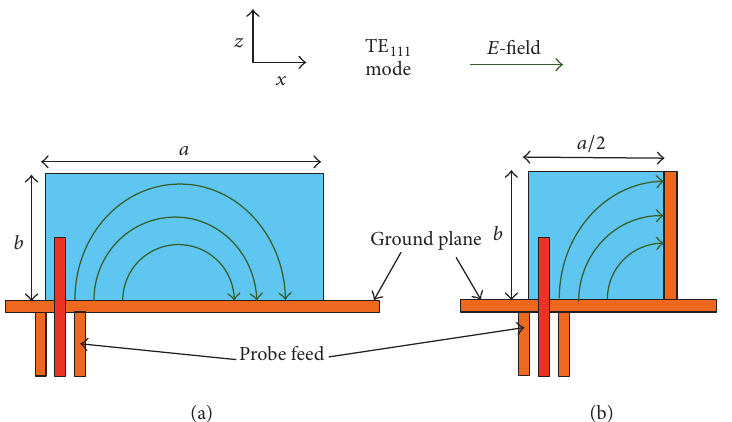
Figure 14: Cross-sectional view of a probe-fed rectangular DRA (a) and its miniaturized version (b) by placing a conducting plate at 𝑥 = 𝑎/2 .